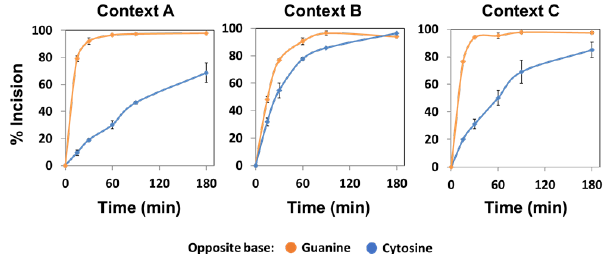
Figure 4. Effect of sequence context and base opposite the abasic site on the AP endonuclease activity of native ARP. Cell extracts from fpg −/− plants (10 μg) were incubated at 37 °C with 20 nM DNA substrates (contexts A, B or C) containing an AP site opposite guanine (orange) or cytosine (blue). After stabilization with NaBH 4 , the reaction products were separated by denaturing PAGE, detected by fluorescence scanning and quantified. Data are the mean and standard error from three independent experiments.